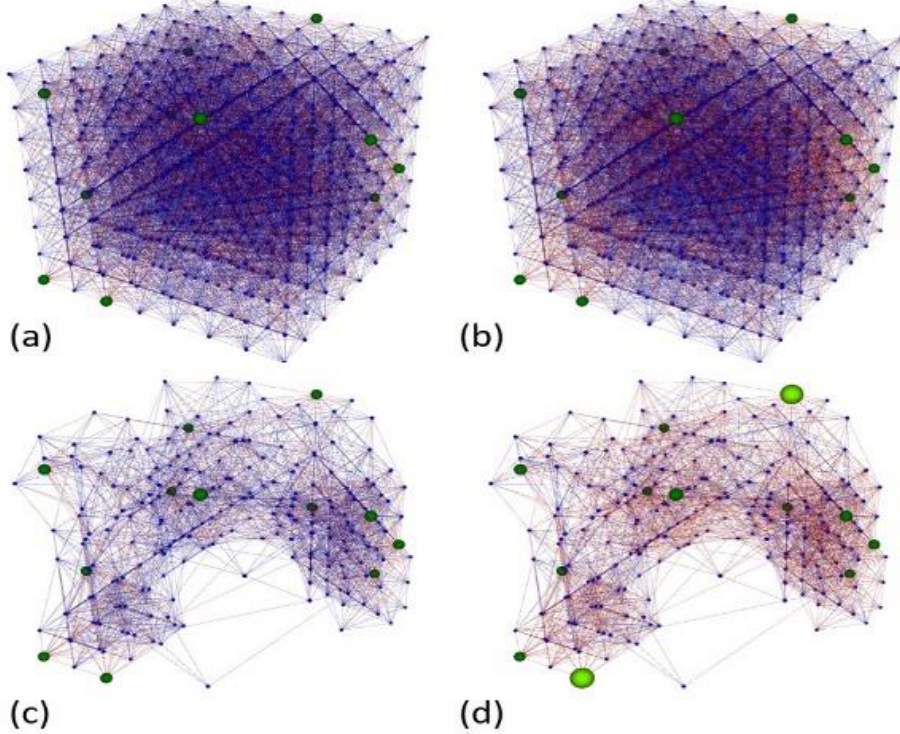
Figure 5. NeuCube model ( a ) before and ( b ) after training. Functional neurons and connections ( c ) before and ( d ) after training. Green dots indicate the input nodes, and brighter green dots indicate that the node fired a spike at the particular time of the snapshot. Blue and red lines indicate positive and negative connections, respectively. Each input odor sample is learned as a deep spatio-temporal pattern of connections.